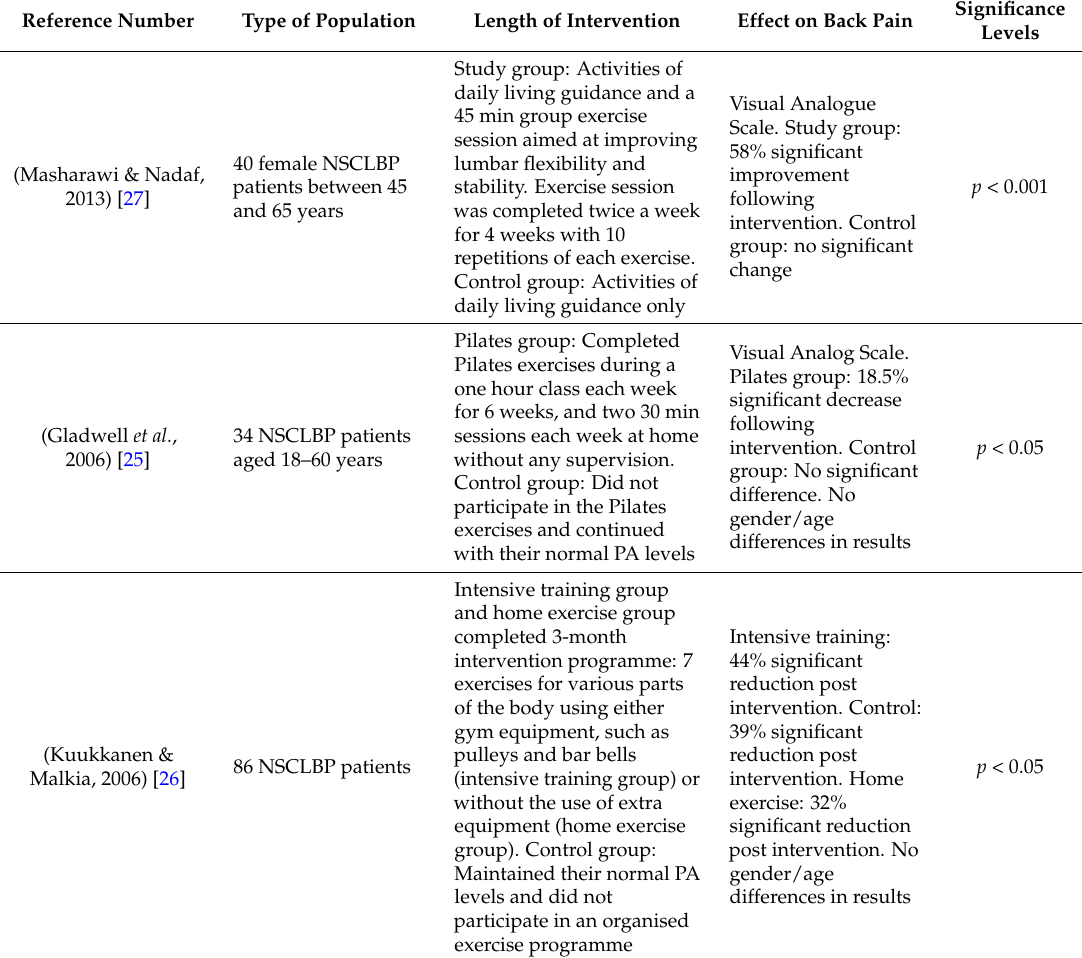
Table 3. Flexibility intervention programmes for NSCLBP